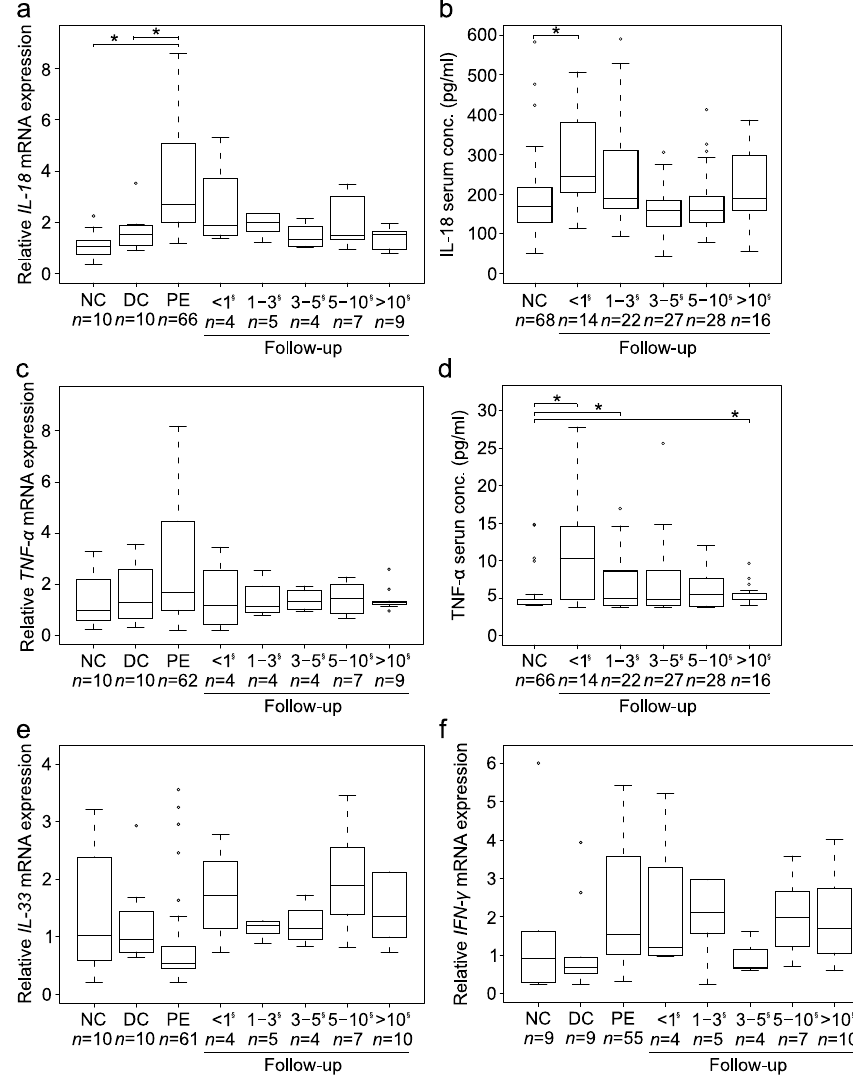
Figure 5. Expression of several cytokines related to IL-8. Box plots (median, interquartile range and 90th percentile) of ( a ) liver IL-18 mRNA expression (fold-change) and ( b ) serum IL-18 concentration (pg/mL), ( c ) liver TNF mRNA expression, ( d ) serum tumor necrosis factor-alpha (TNF- α ) concentration (pg/mL), ( e ) liver IL-33 mRNA expression, and ( f ) liver IFN mRNA expression in normal controls (NC), disease controls (DC), biliary atresia patients at portoenterostomy (PE) and during follow-up following PE * p < 0.05. § = Years after PE circles =